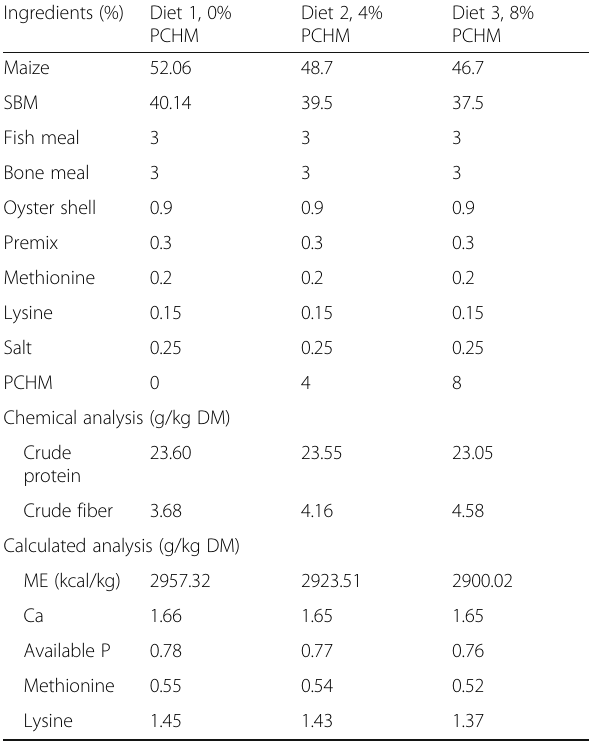
Table 2 Composition of experimental diets (starter phase)